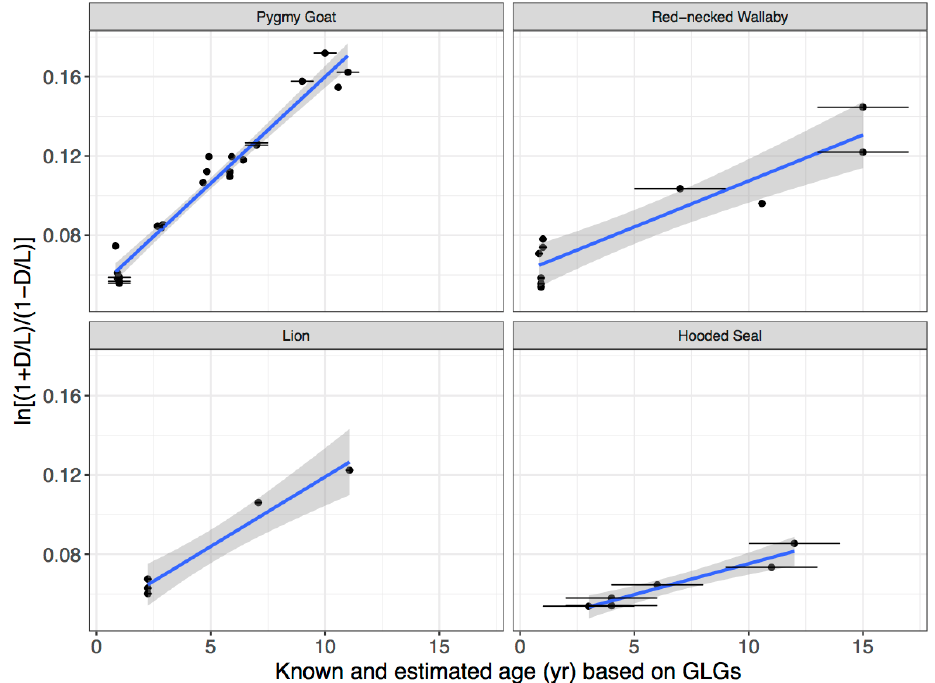
Fig. 2 . Regression line from the bootstrap study of D/L ratios against known and estimated ages for the pygmy goat, lion, red-necked wallaby and hooded seal. The slope of the regression line corresponds to twice the racemization rate (2 k ) and the intercept corresponds to twice the (D/L) Asp